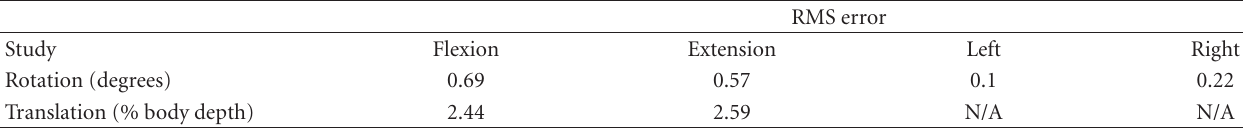
Table 1: Accuracy: combined results from two calibration models for four bending modes.